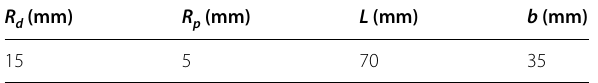
Table 1 Geometry parameters for the moulds